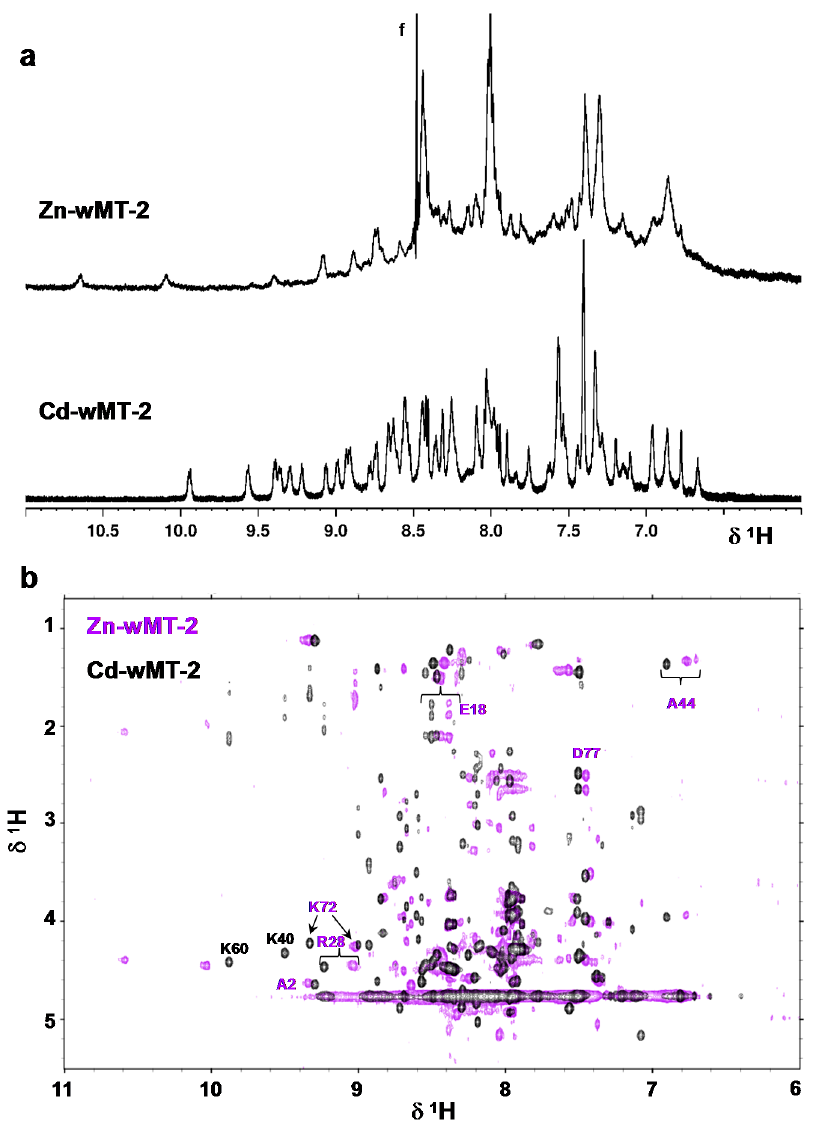
Figure 6. Comparison of 1D 1 H ( a ) and 2D [ 1 H, 1 H] TOCSY ( b ) NMR data for Zn- and Cd-wMT-2. Only the fingerprint regions (consisting mainly of N–H backbone resonances) are shown. Although all four spectra show considerable dispersion of N–H resonances, especially the comparison in ( a ) demonstrates that Zn-wMT-2 is considerably less well folded than Cd-wMT-2. Selected assigned residues are labelled in ( b ) for both proteins; labels in purple refer to residues observed for both forms; black labels refer to residues that were assignable for Cd-wMT-2 only. The “f” in ( a ) refers to the signal for formate at 8.48 ppm.